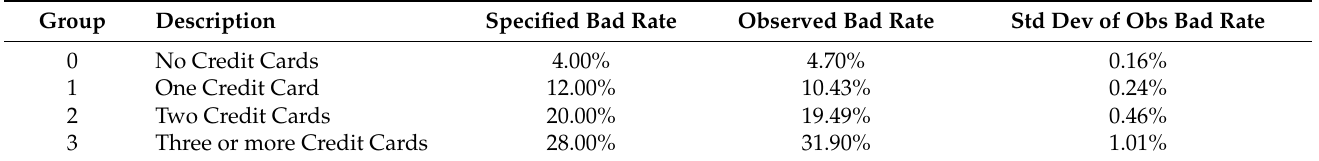
Table 6. Credit cards with other